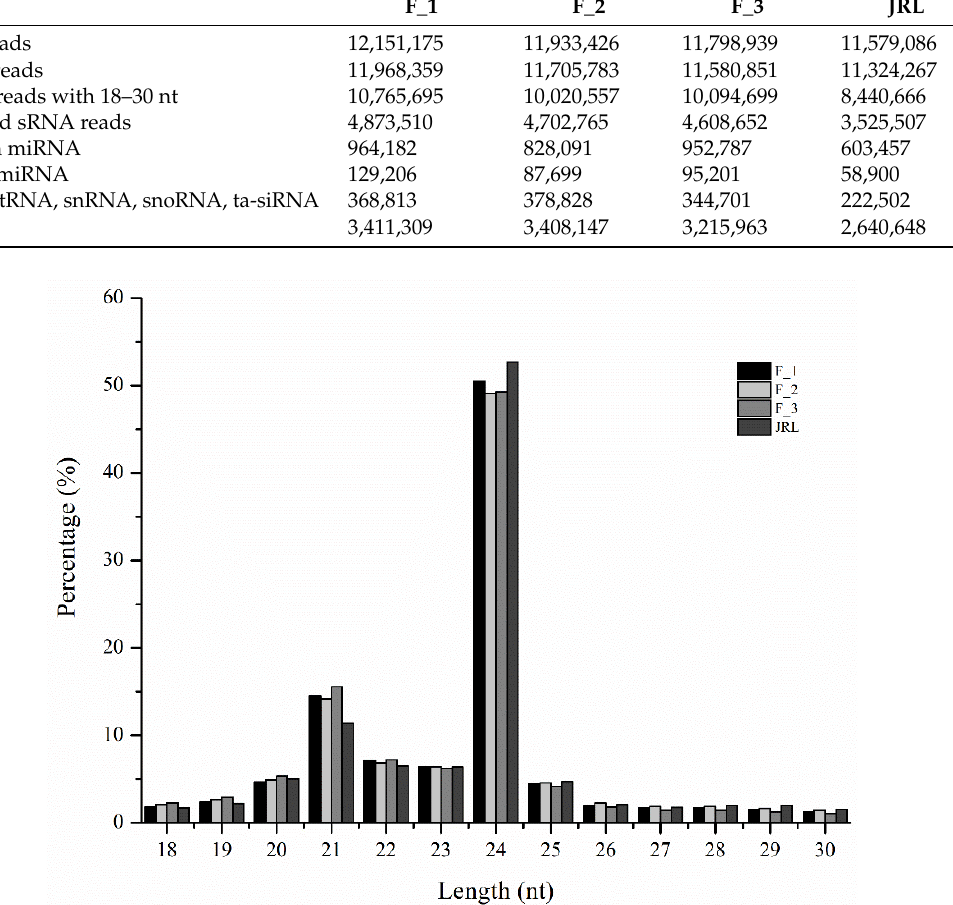
Figure 1. Length distribution and frequency of sRNAs in the four J. regia libraries. F_1, female flower buds before flower induction; F_2, female flower buds during flower induction; F_3, female flower buds after flower induction; JRL, leaf buds during flower induction.